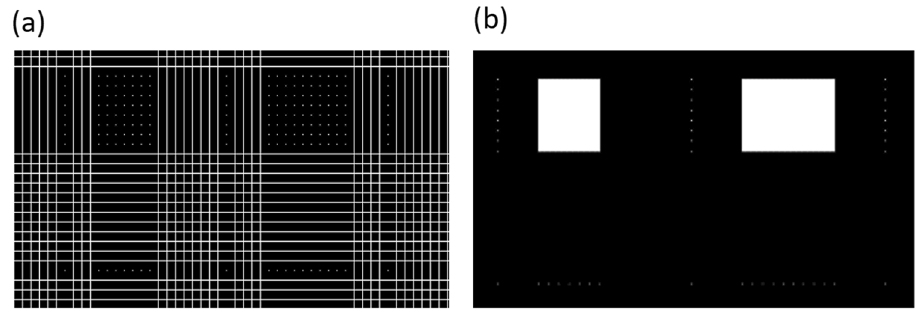
Figure 12. ( a ) Shows white lines defining areas excluded from classification, and white dots denoting areas classified as kidney (or spleen). ( b ) Shows the effect of merging equidistant points.